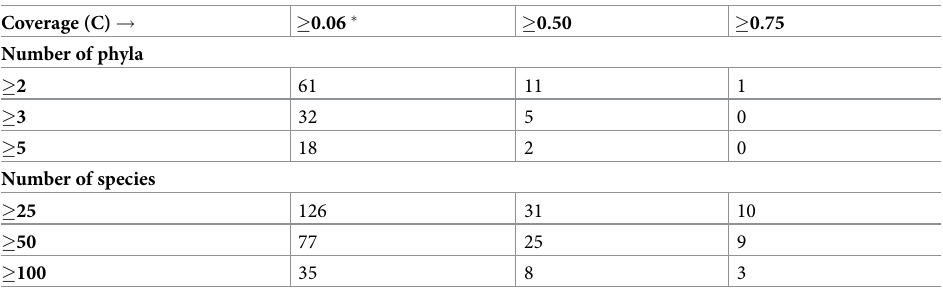
Table 3. Numbers of prion-like protein families (basic PP set) for various